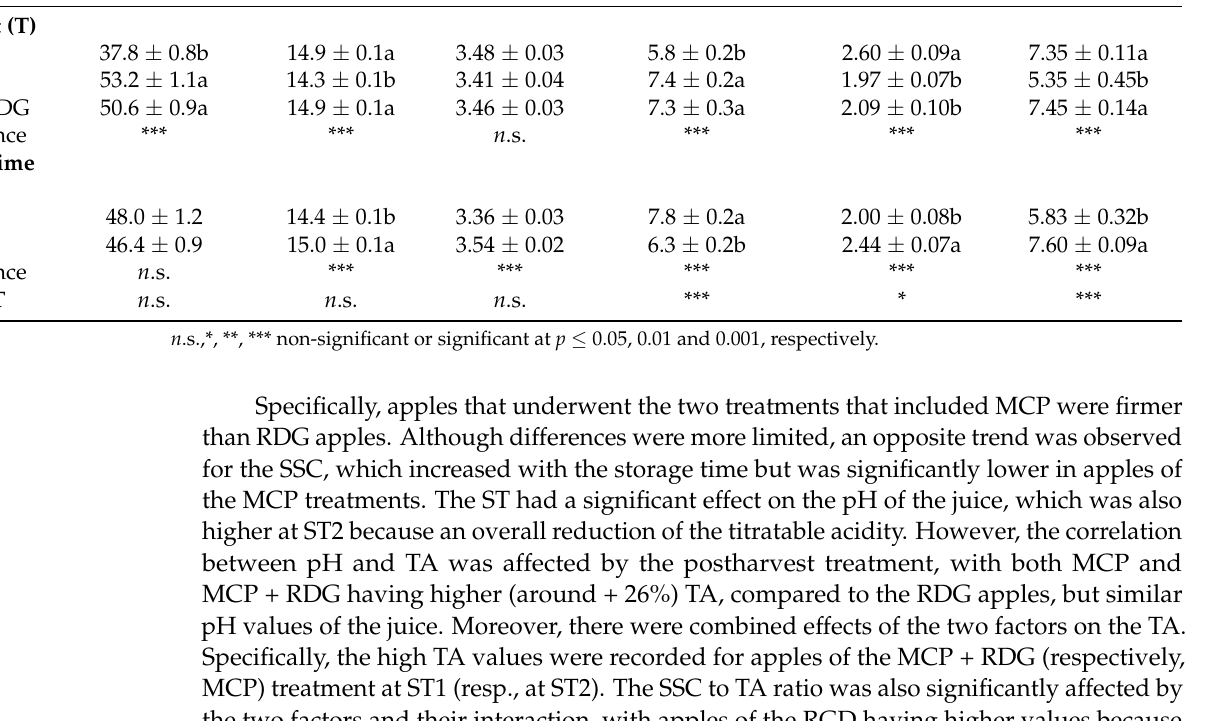
Table 2. Effect of the postharvest management treatment (T), storage time (ST) and T × S interaction on apple flesh firmness, soluble solids content (CSS), pH, titratable acidity (TA), SSC/TA ratio and starch pattern index (SPI). Source